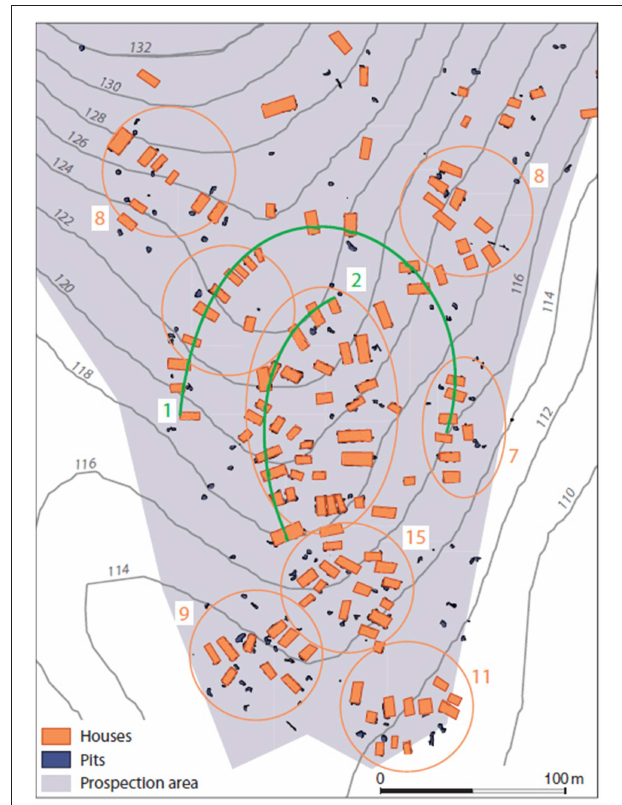
FIGURE 8 | Interpretative plan of the Trypillia Phase BI/II site of Singerei, Moldova, showing the overall survey area and geophysical anomalies interpreted as houses and pits (source: Rassmann et al., 2016b, Figure